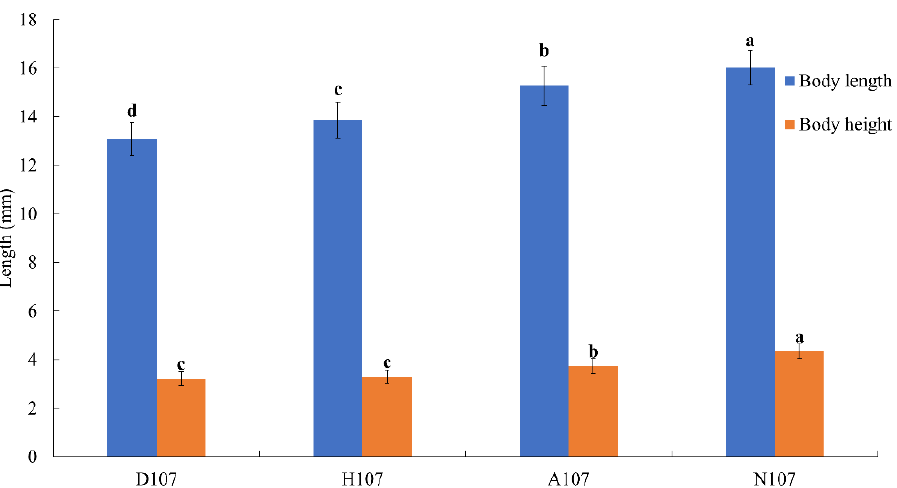
Figure 1. Body length and height of L. crocea in the different treatment groups on Day 27. Bars with different letters were considered significant at p <0.05.